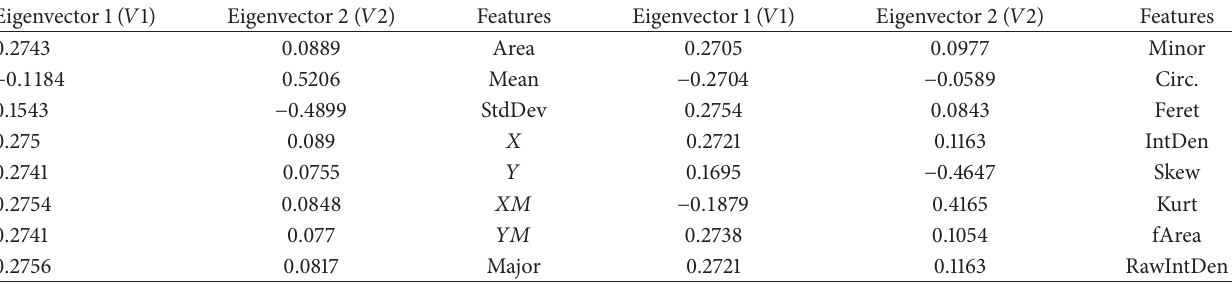
Table 9: Eigen vectors for each feature.